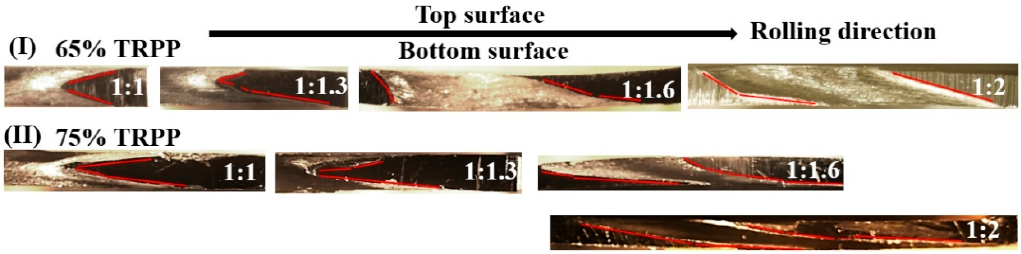
Figure 6. Change in inclination profile of pins at ratios 1:1–1:2 with TRPPs of 65% and 75% for the whole sheet thickness.